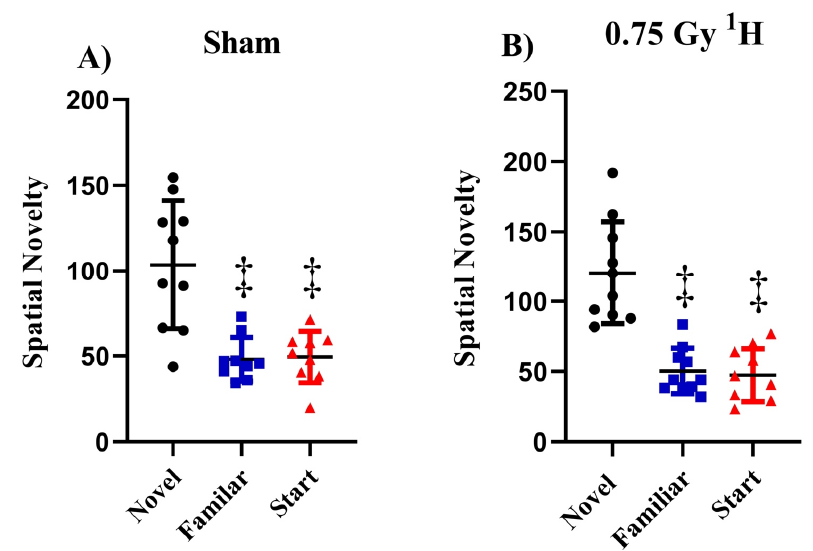
Figure 1. Y-maze. Both sham-irradiated ( A ) and 1 H-irradiated ( B ) mice significantly preferred exploration of the novel arm compared to the familiar and start arms ** p < 0.01.